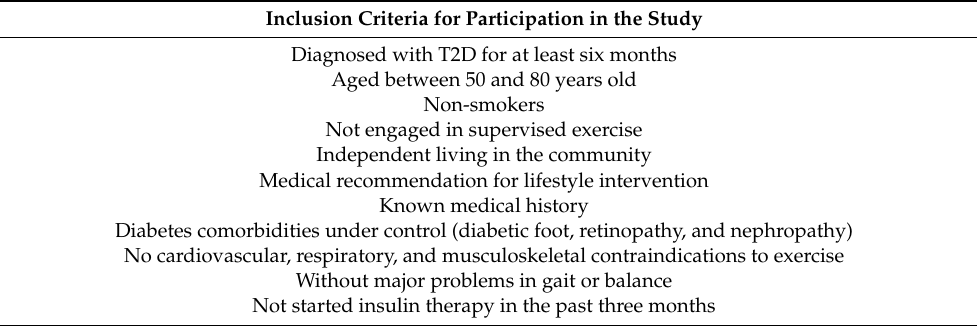
Table 1. Inclusion criteria for participation in the study.